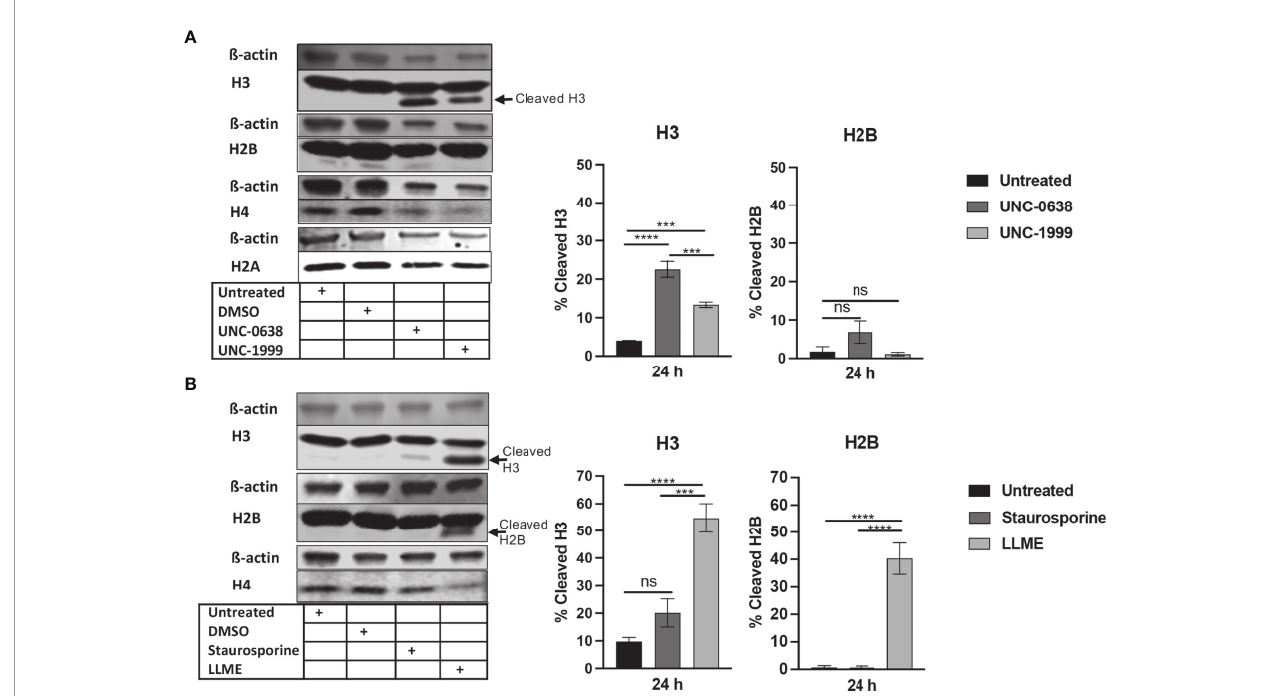
FIGURE 1 | Histone 3 (H3) is cleaved in human mast cell leukemia cells in response to cytotoxic agents. HMC-1 cells (0.5 x 10 6 cells/ml) were either left untreated or incubated for 24 h with either (A) UNC-0638 (25 m M), UNC-1999 (50 m M), (B) staurosporine (1 m M) or H-Leu-Leu-OMe (LLME) (400 m M). Samples corresponding to equal numbers of cells were subjected to Western blot analysis for histone 3 (H3), H2B, H4 and H2A, with ß-actin as loading control. Quanti fi cation of the signal intensity for cleaved H3 and H2B, as % of total H3 and H2B, is shown in the right part of the panels. The presented data are representative of at least two independent experiments and are given as mean values ± SEM (n=3). ***p ≤ 0.001; ****p ≤ 0.0001. ns, not signi fi